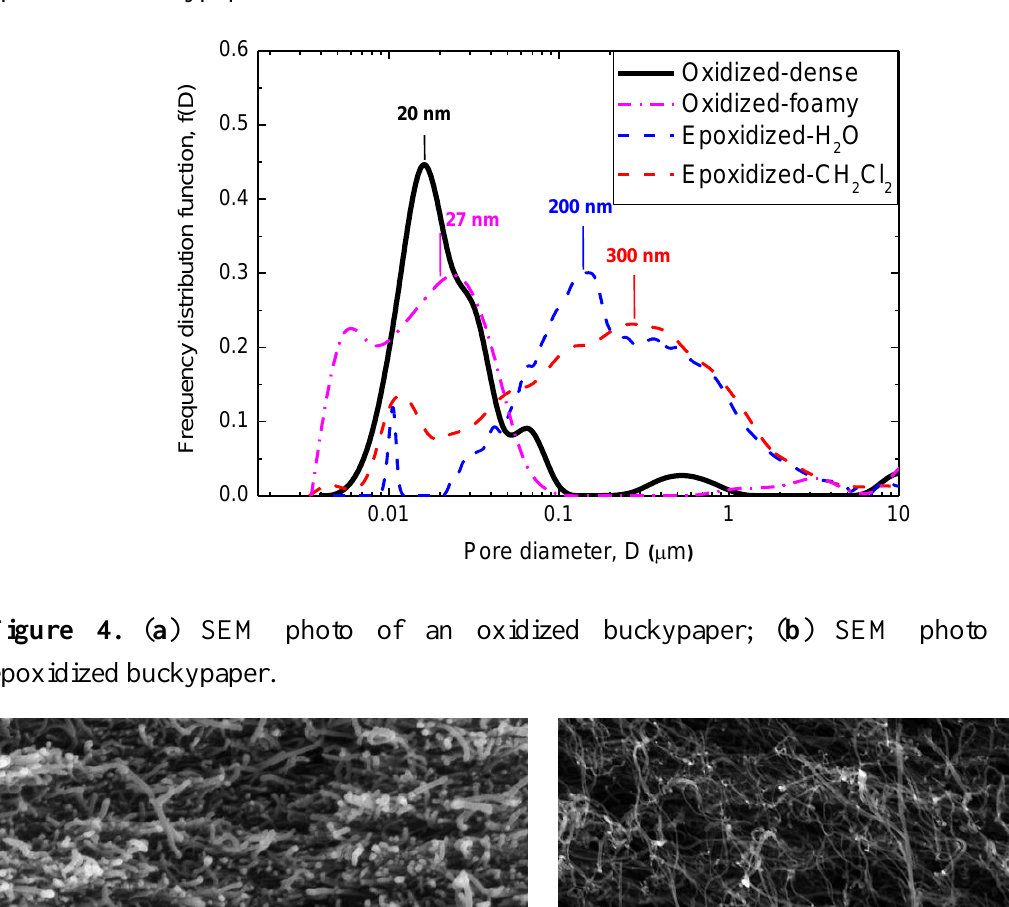
Figure 3. Pore size distribution from Hg intrusion curves of oxidized and epoxidized buckypapers.